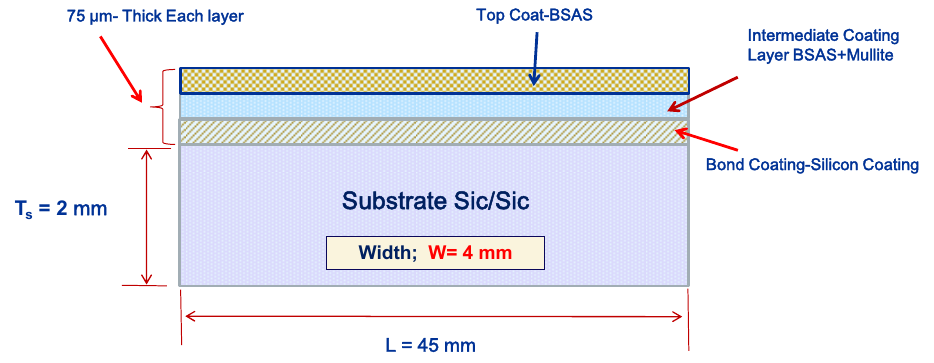
Figure 6. Schematics of EBC coated MI SiC/SiC composite specimen. BSAS: barium strontium aluminum silicate.